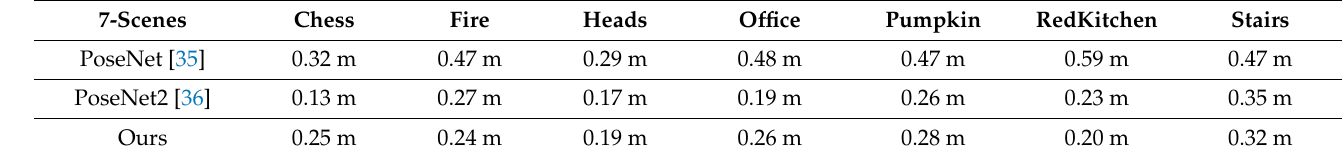
Figure 10. Localization on the 7-Scenes dataset; Chess, Fire, Heads, Office, Pumpkin, Red Kitchen and Stairs. Table 6. Comparison of localization error on the 7-scenes dataset.